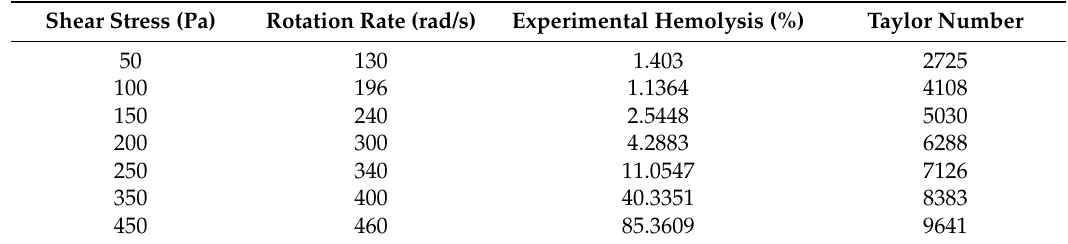
Table 1. Model conditions for Couette viscometer experiments [16].